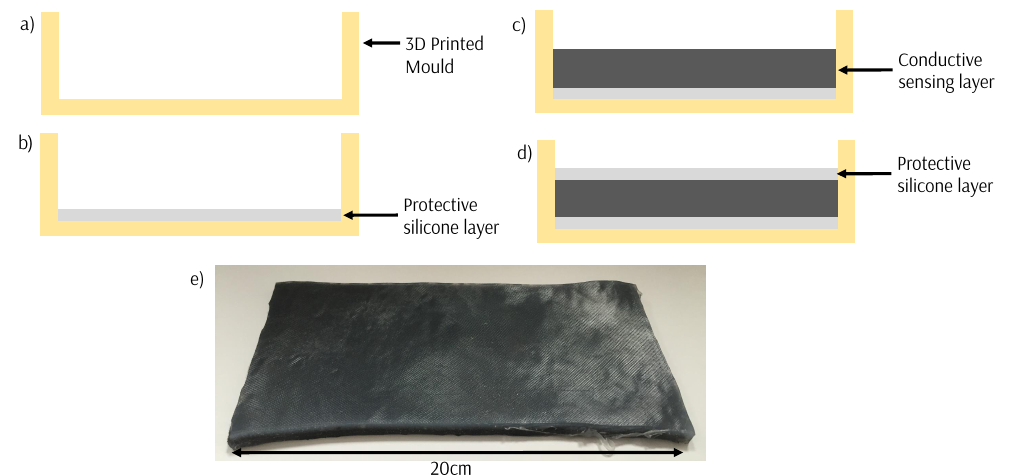
Figure 2. The fabrication process to develop sheets of the sensing material. ( a ) Create a 3D-printed mold for the sensor. ( b ) Cure a thin layer of silicone in the bottom of the mold. ( c ) Create the sensing material and pour into the mold and cure. ( d ) Add a final thin protective layer of silicone. ( e ) The sensing sheets